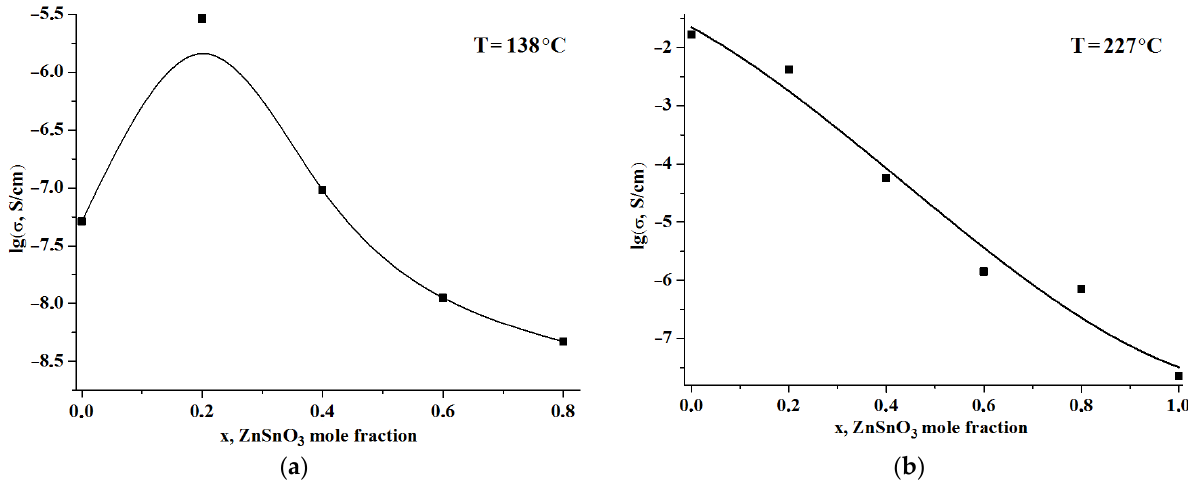
Figure 8. Isotherms of the proton conductivity for the composite systems (1–x)CsH 2 PO 4 –xZnSnO 3 at di ff erent temperatures: 138 °C ( a ) and 227 °C ( b ).